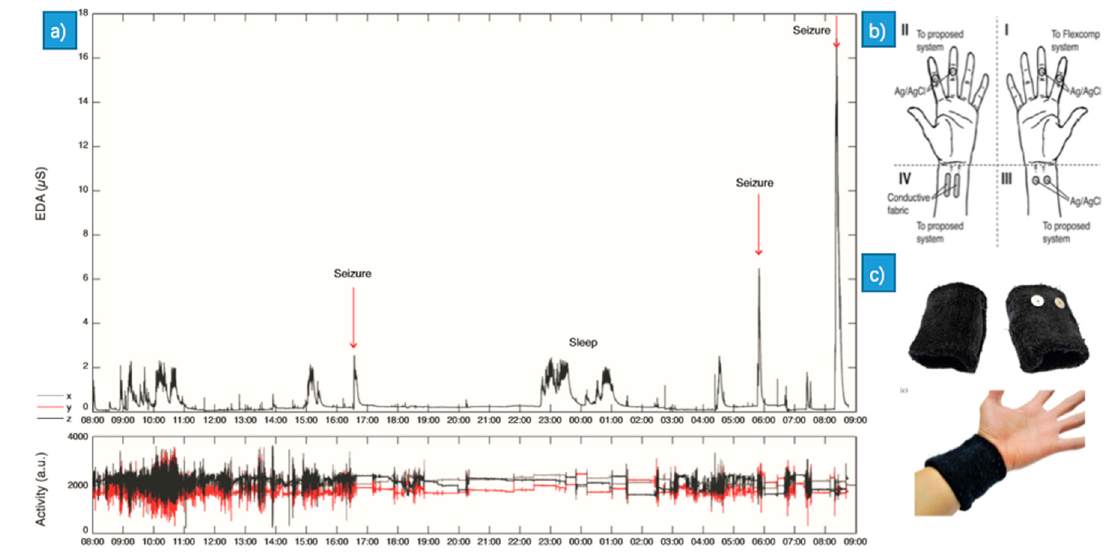
Figure 9. ( a ) Monitoring of epileptic seizures using EDA; ( b , c ) Wearable GSR